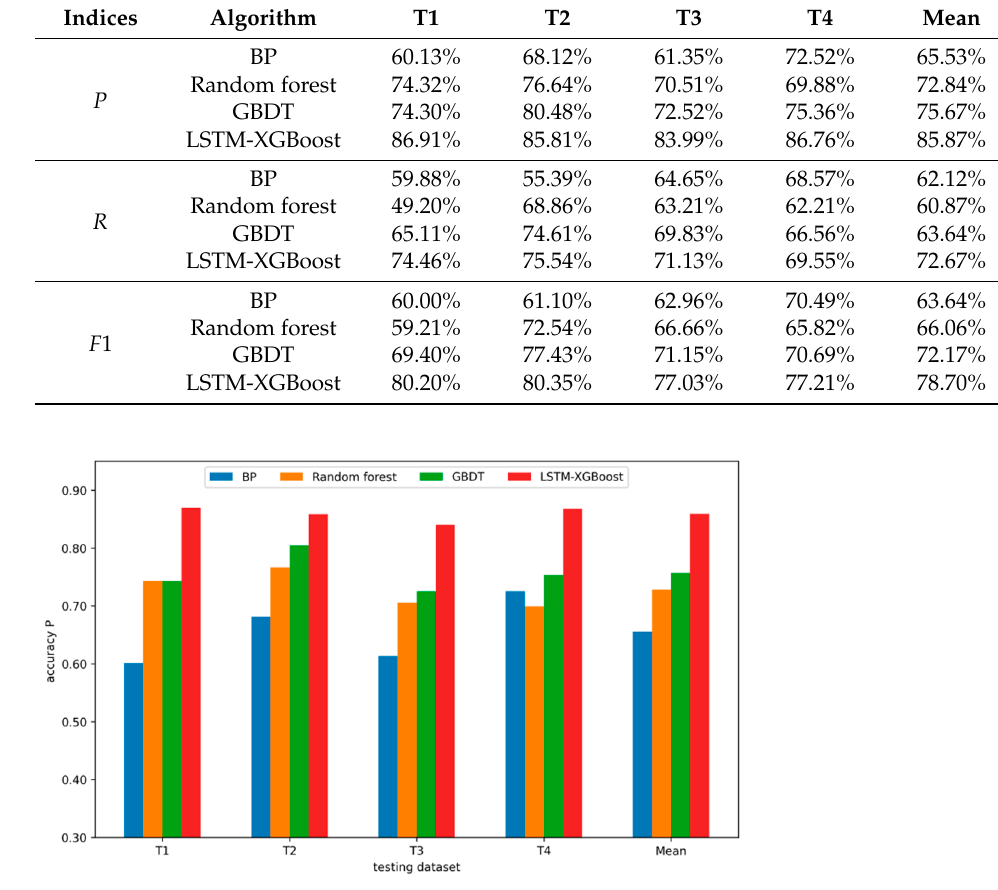
Figure 14. F1 of heavy overload prediction models of public transformer based on each algorithm. From the perspective of business, grassroots business units pay more attention to the prediction accuracy of whether a public transformer will be overloaded in the short term. The high accuracy of heavy overload prediction can better assist in the active repair and load monitoring of public transformers. Table 8 reveals that the LSTM-XGBoost algorithm attains the highest accuracy of heavy overload prediction accuracy in all four test periods, with an average of about 85.87% and a recall rate of 72.67%. The results indicate that this study’s heavy overload prediction method outperforms current methods. 5. Conclusions This study extracts heavy overload feature variables from four dimensions, including basic parameter information, weather, time, and recent load, and constructs a second highest load rate prediction model based on the LSTM algorithm to obtain the predicted value of the second highest load rate. After aggregating the heavy overload feature vari- ables and the predicted second highest load rate, the XGboost algorithm constructs a short-term heavy overload prediction model for distribution transformers. After experi- mental verification, the following conclusions are drawn: (1) The proposed LSTM-XGBoost model considers the influencing factors of heavy over- loads, such as weekday, month, and temperature, and analyzes the impact of load prediction on the heavy overload. The results highlight that the proposed method improves short-term heavy overload prediction accuracy.